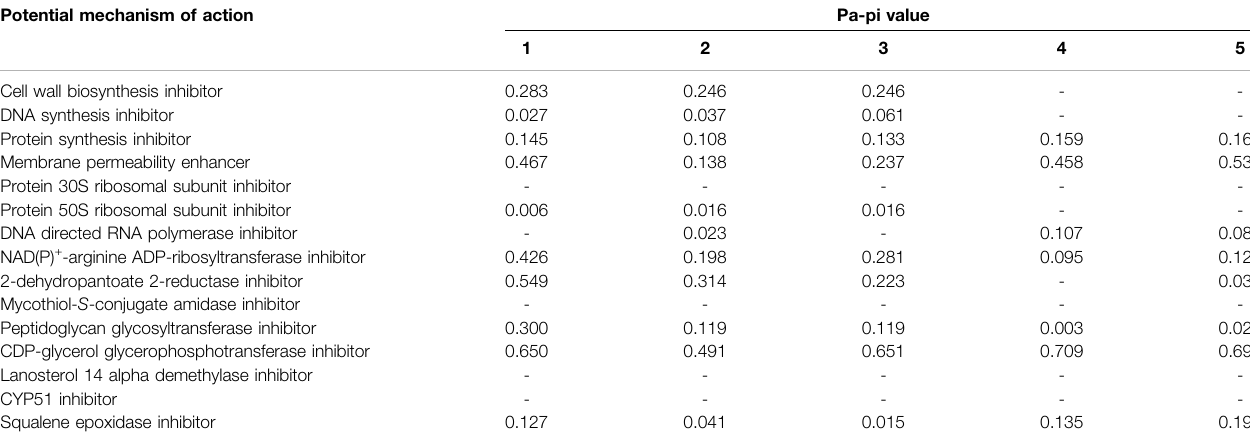
TABLE 2 | In-Silico test prediction of potential mechanism of action using the PASS online tool (Filimonov et al., 2014). Potential mechanism of action